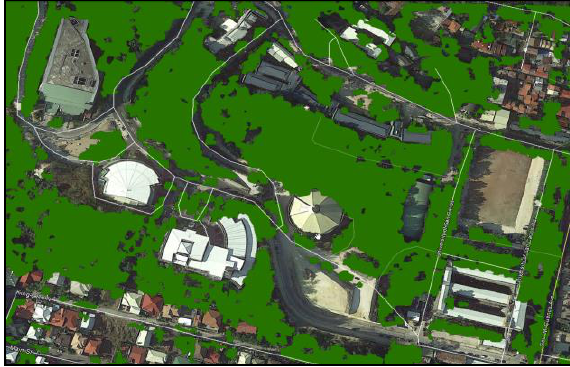
Figure 4. Tree canopy cover map of the University of San Carlos as overlaid in Google Earth.